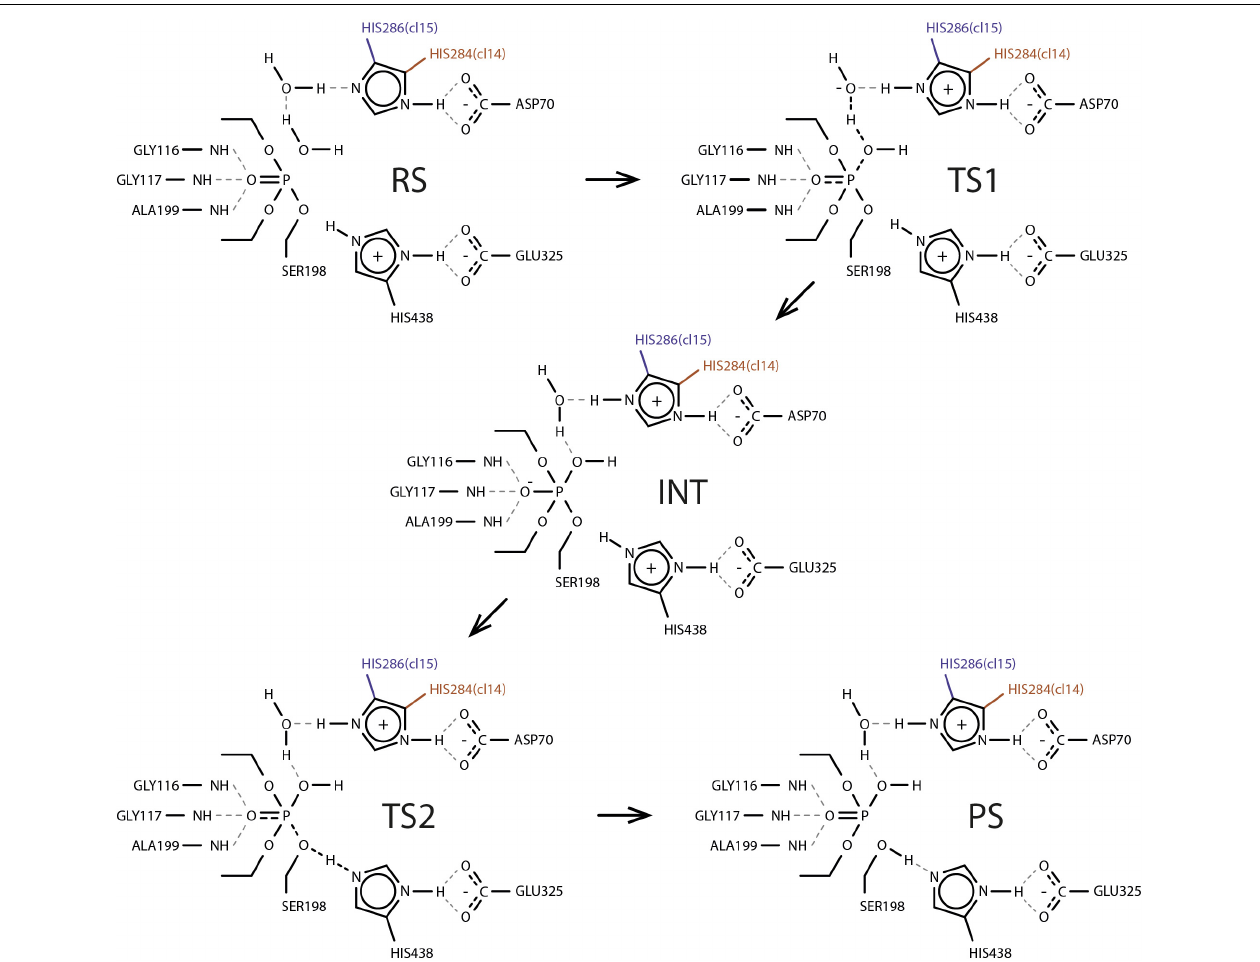
FIGURE 4 | Proposed generalized reaction mechanism of paraoxon hydrolysis by clones 14 and 15 based on trajectory snapshots. RS, reactant state; TS1, first transition state; INT, intermediate; TS2, second transition state; PS, product state.